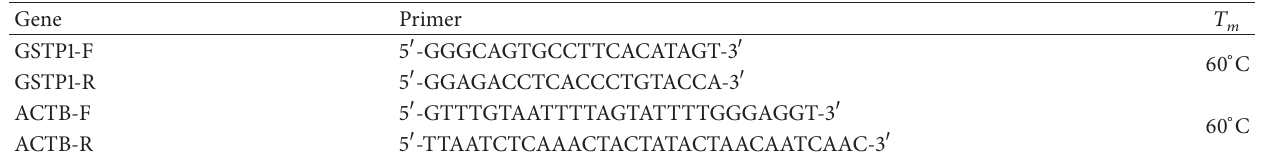
Table 2: The list of qPCR